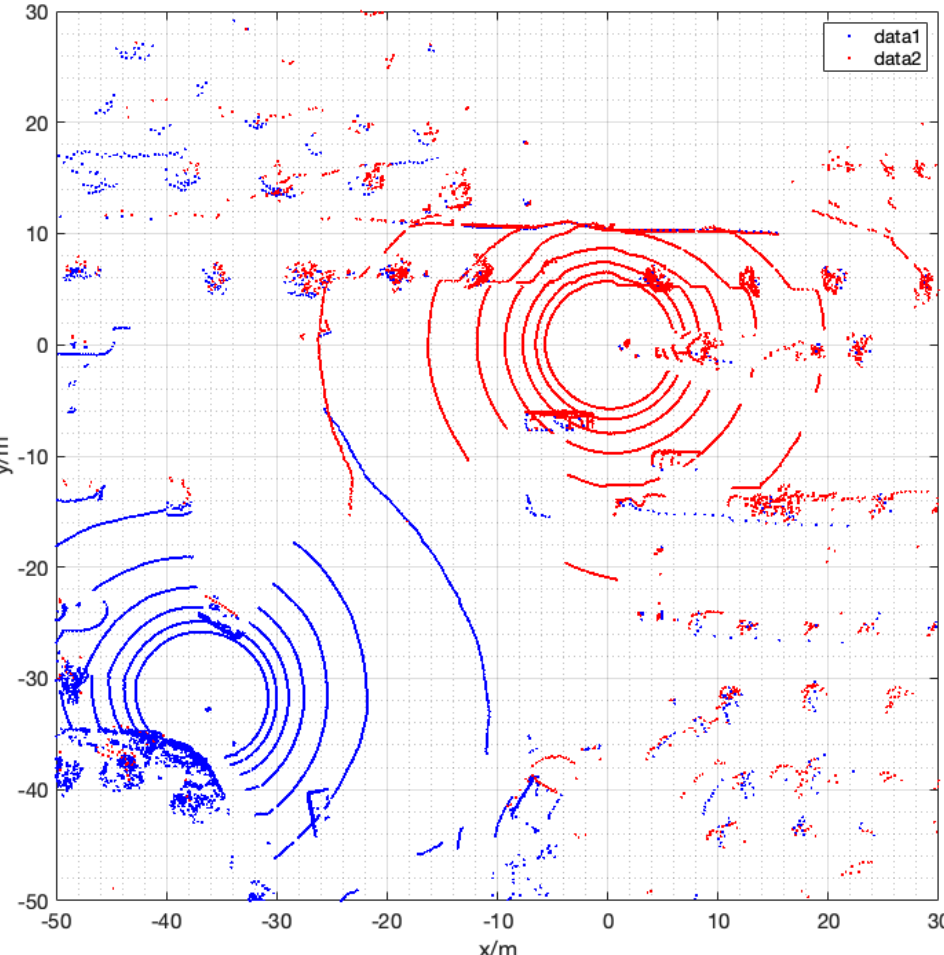
Figure 13. Results of registration in the intersection